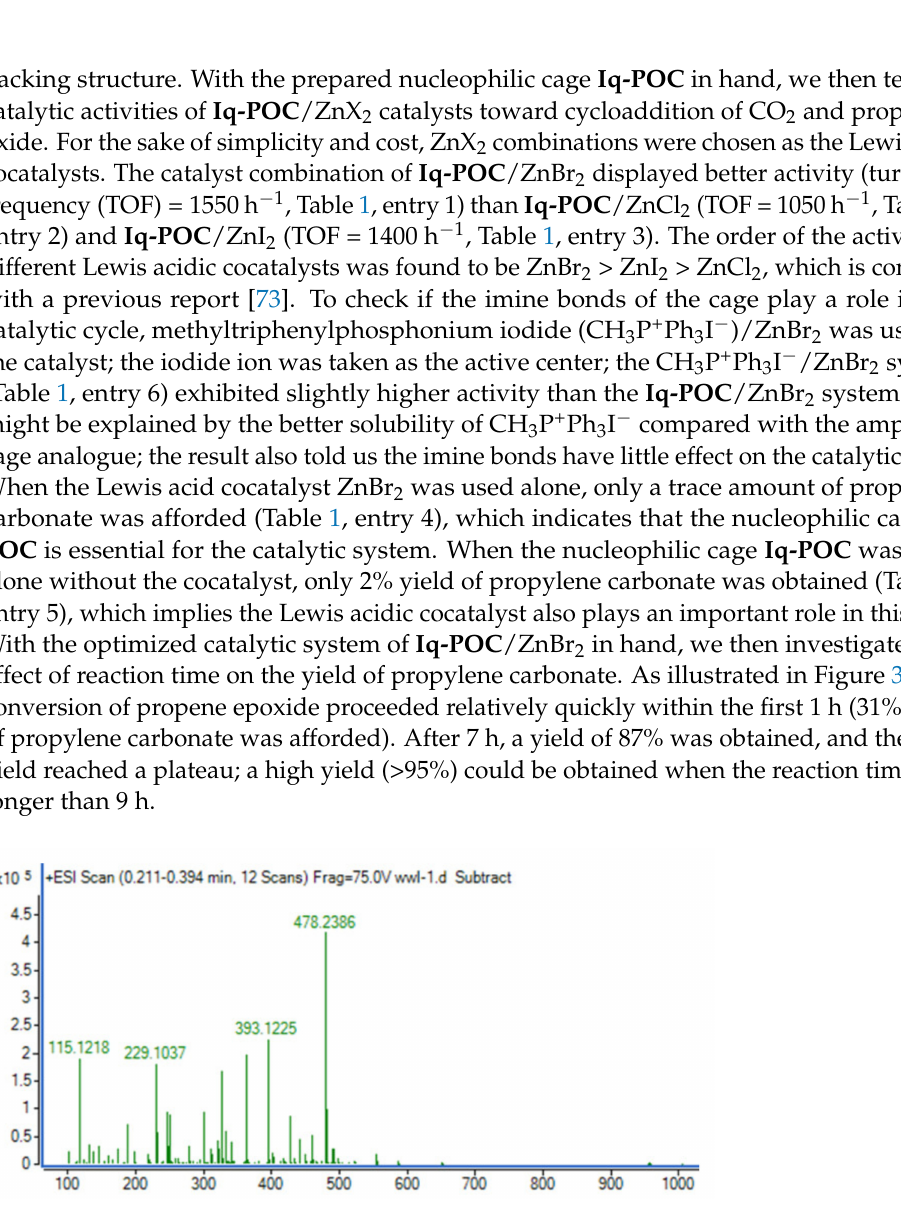
Figure 2. Electrospray ionization high resolution mass spectrometry (ESI-HRMS) of the cage Iq-POC . Table 1. Catalytic activities of different catalytic systems in the cycloaddition reaction of CO 2 and propylene oxide 1